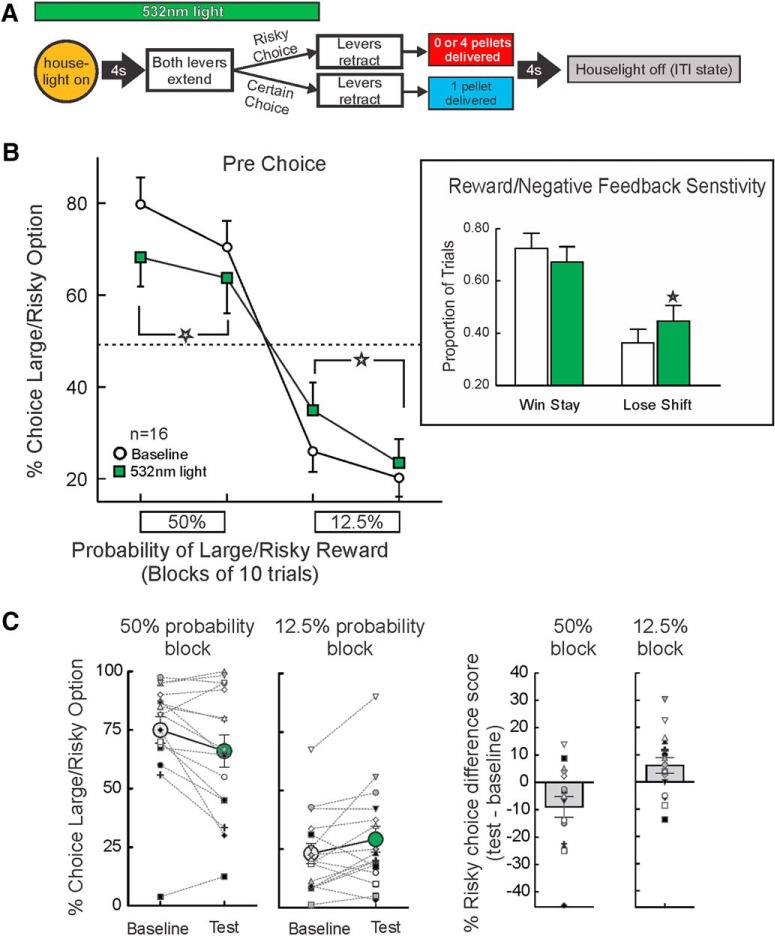
Inhibition of BLA terminals in the NAc before choice alters action selection during probabilistic discounting. A, Optogenetic manipulation and task design. Light was delivered at the start of every free choice trial until lever press. B, Percentage choice of the large/risky option under baseline conditions and during optogenetic tests. Inhibition before choice reduced risky choice during the higher, 50% probability block, and increased risky choice in the lower, 12.5% block (n = 16). Inset, Pre-choice optogenetic inhibition increased lose-shift behavior, but did not affect win-stay behavior. C, Individual data, plotted in terms of the percentage of risky choices under baseline and optogenetic test conditions (left panels) and the difference score of these values between baseline and test (right panels). Large circles and bars display the group mean ± SEM for the left and right panels, respectively. In the majority of animals tested, optogenetic inhibition reduced/increased risky choice relative to baseline in the 50%/12.5% probability blocks, respectively. For this and all other figures, error bars are SEM, and stars denote p < 0.05 compared to baseline.